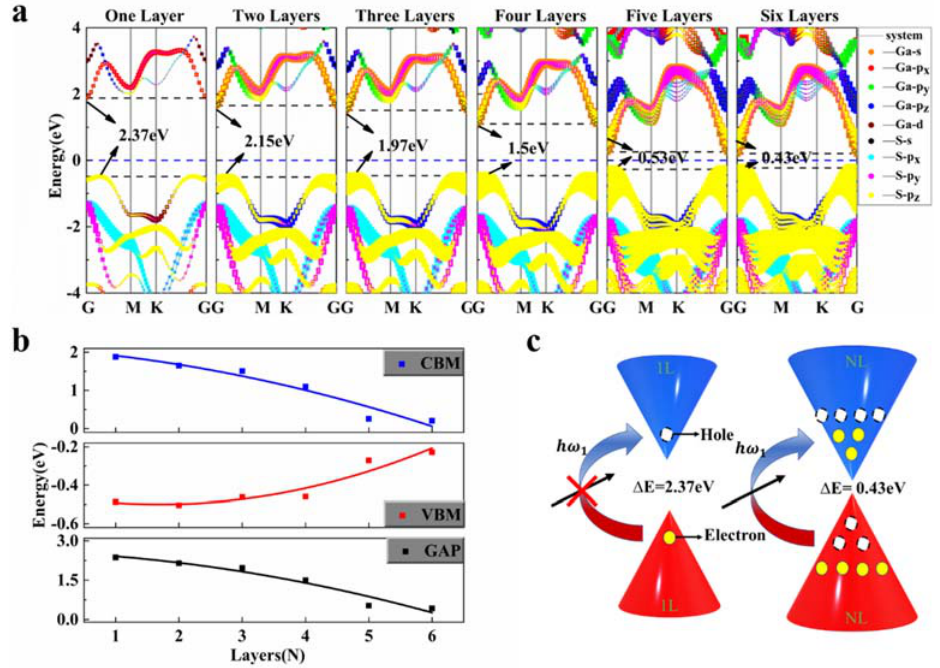
Figure 4. The PBE calculated band structure ( a ) 1–6 Layers GaS, the size of the dots in the bands indicates the weight of the electronic orbital. ( b ) The dependence of band gap, VBM and CBM on number of layers. ( c ) Schematic diagram of photogenerated electron leap in monolayer and multi ‐ layer GaS.